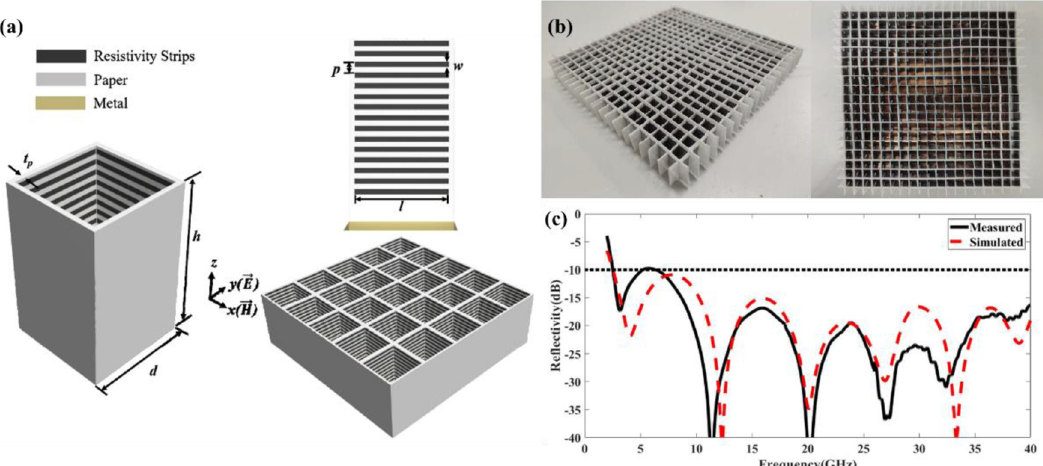
Fig. 9. (a) Schematic of the polarization-independent absorber. (b) Structure of the polarization-independent absorber. (c) Re fl ectivity of the polarization-independent absorber from the simulation and measurement [103]. Reproduced with permission from Y. Yang et al., 2019 International Symposium on Antennas and Propagation (ISAP), IEEE, 1, 4 (2019). Copyright 2019 IEEE.